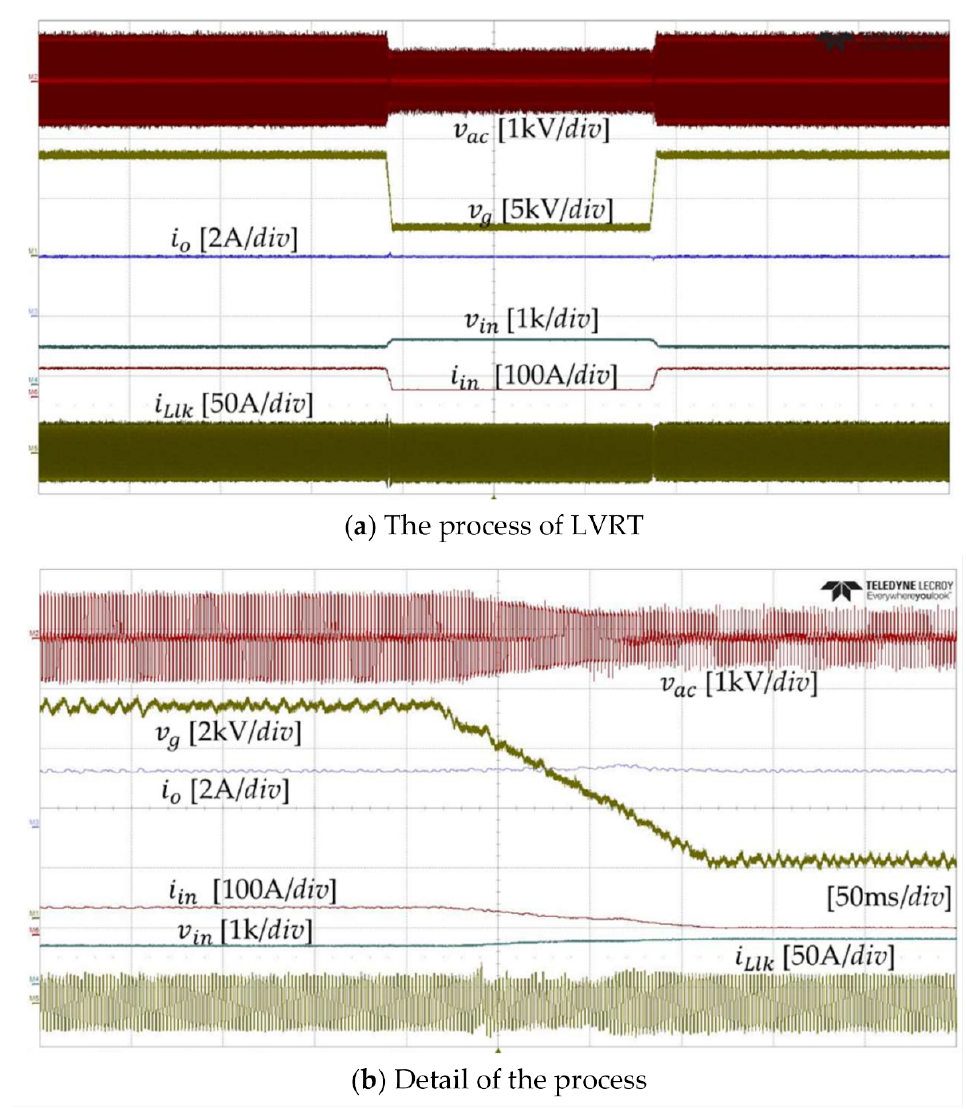
Figure 28. Experimental result of the process of LVRT (Grid voltage drops